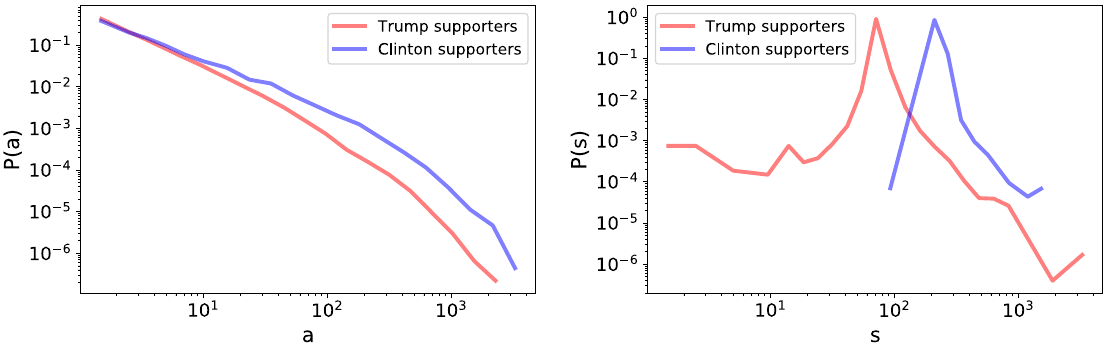
Figure 1. ( a ) Probability distribution of the activity a of users in the Politics network, P ( a ), plotted separately for Clinton and Trump supporters. ( b ) Probability distribution of the average score s of users in the Politics network, P ( s ), plotted separately for Clinton and Trump